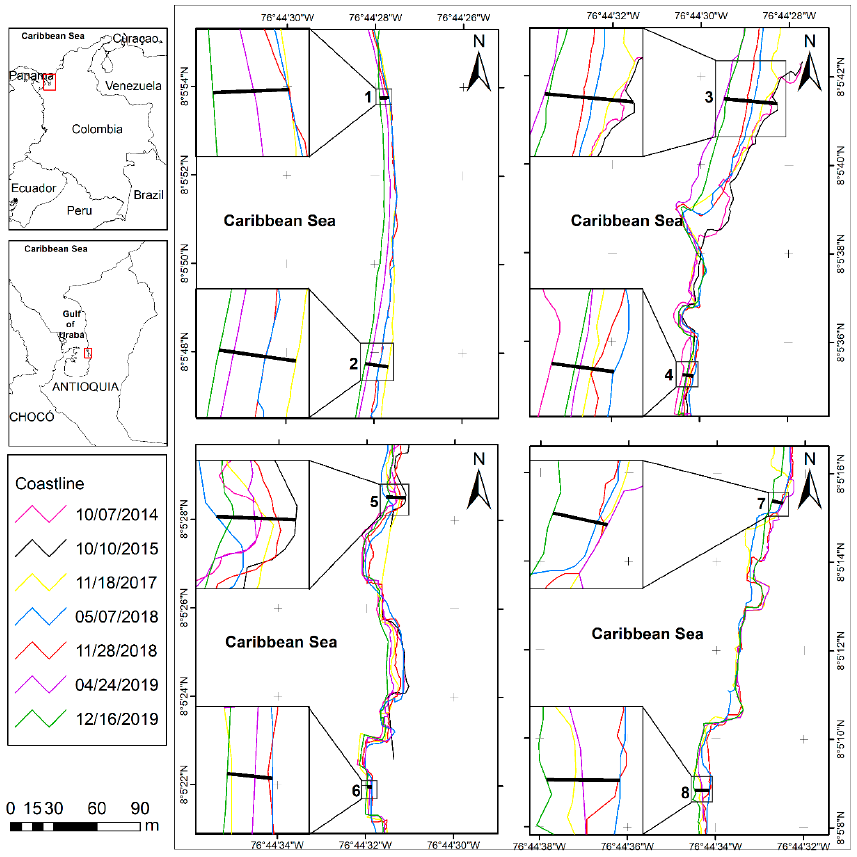
Figure 5. Coastline changes for the urban beaches of Turbo, 2014–2019.